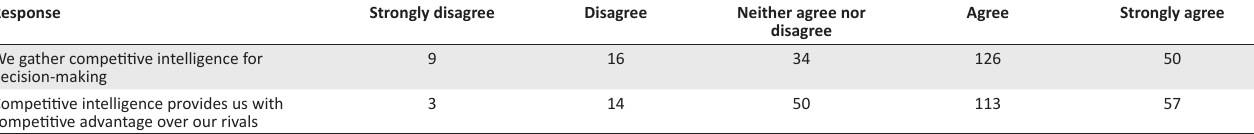
TABLE 10: Frequency of responses to purpose of competitive intelligence practice in the property sector ( N = 239). Response